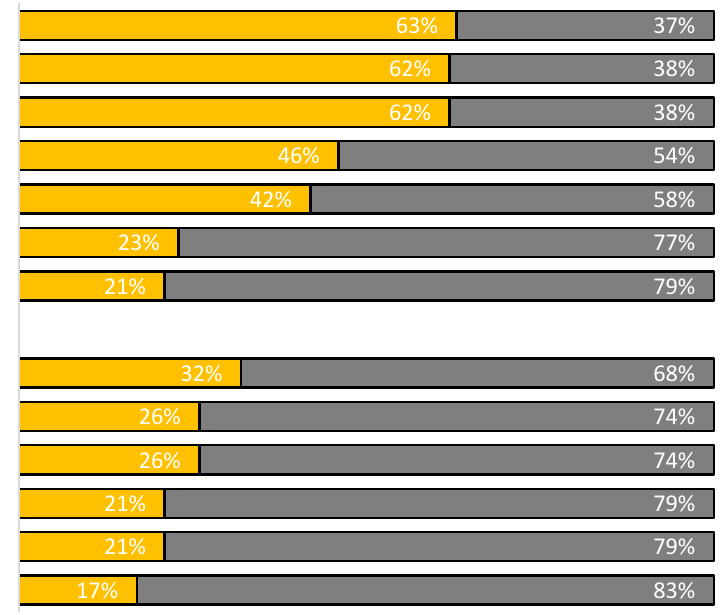
Figure 4. Internal and external barriers to achievement of education and employment goals. Table 2. Correlations between measures of education and employment participation, goals, career development, and perceived